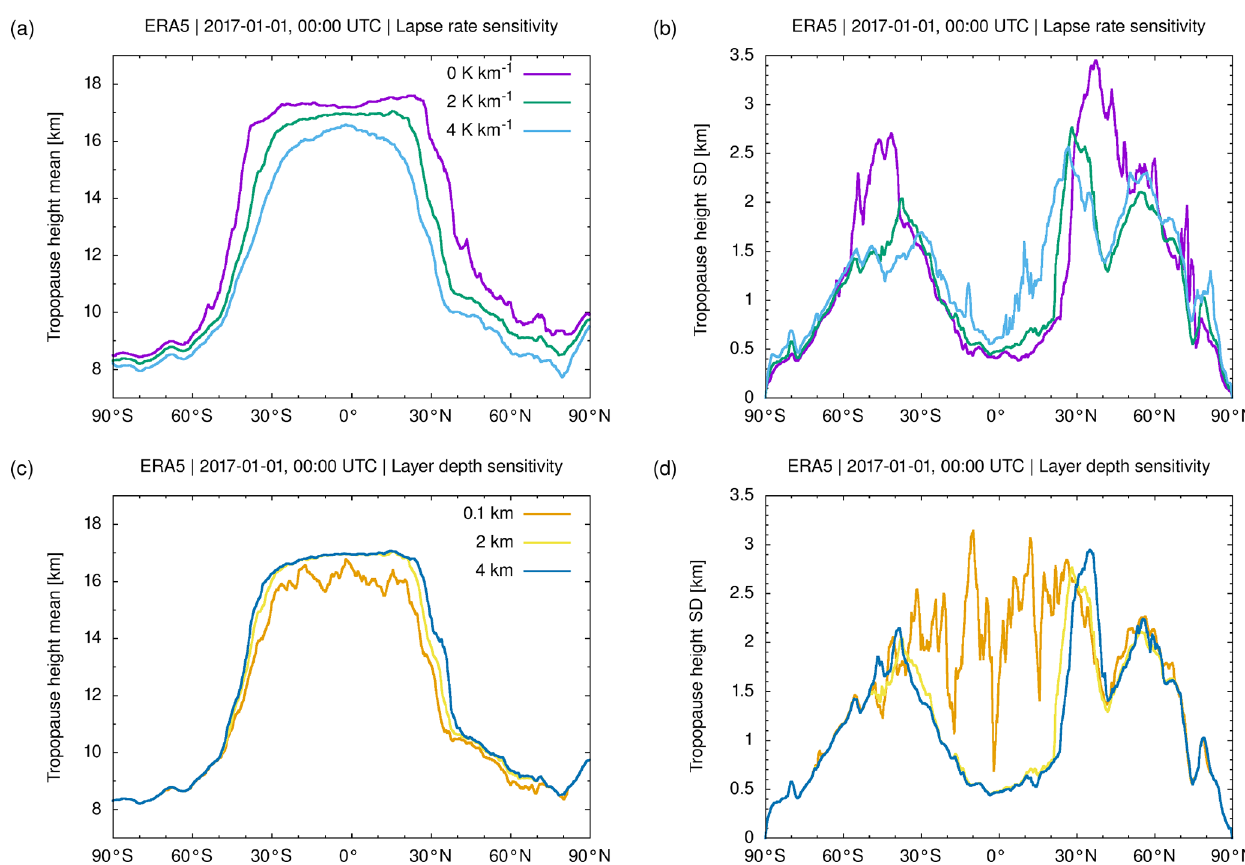
Figure 16. Zonal means (a, c) and standard deviations (b, d) of ERA5 thermal tropopause geopotential heights on 1 January 2017, 00:00UTC. Different curves illustrate the sensitivity of the results on the selected lapse rate threshold (a, b) and the layer depth (c, d) .